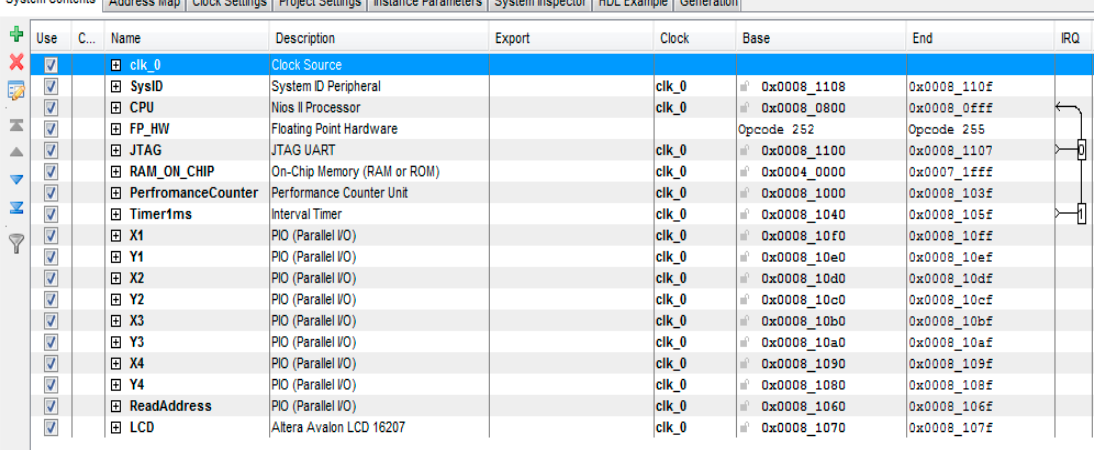
Figure 10. Soft-core processor components and architecture.